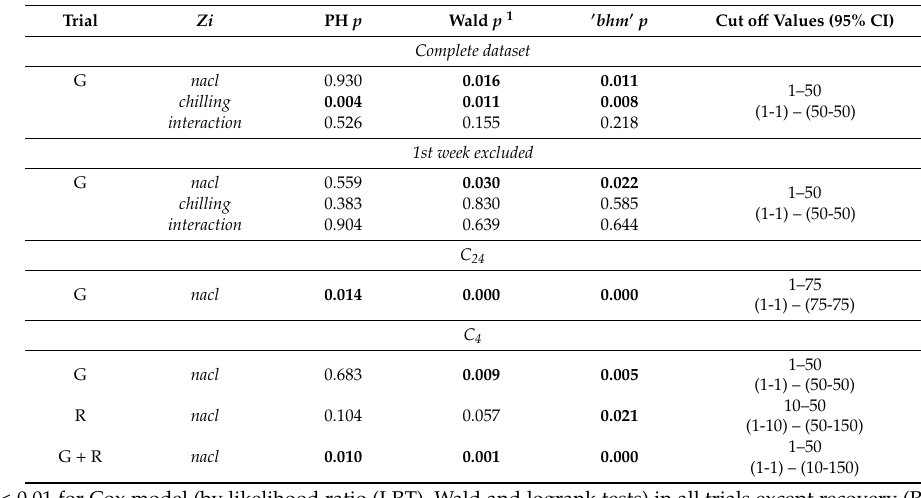
Table 3. Model selection (best models in bold ) by log-likelihood value (LLV), Akaike information criterion (AIC), Bayesian information criterion (BIC); df, degree of freedom. Likelihood ratio (LRT) p -value listed following the order of terms in model formula (significant terms in bold , p < 0.05).